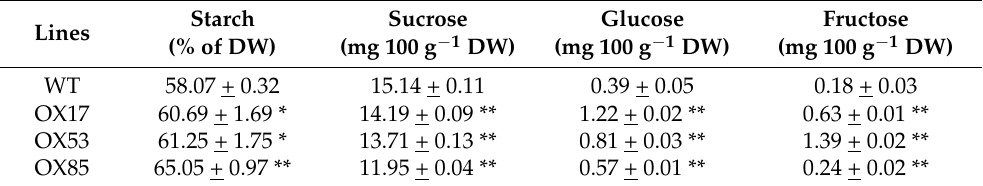
Table 2. Starch and soluble sugar contents in the storage roots of the plastidial phosphoglucomutase- overexpressing (OX) transgenic and wild-type (WT) sweet potato